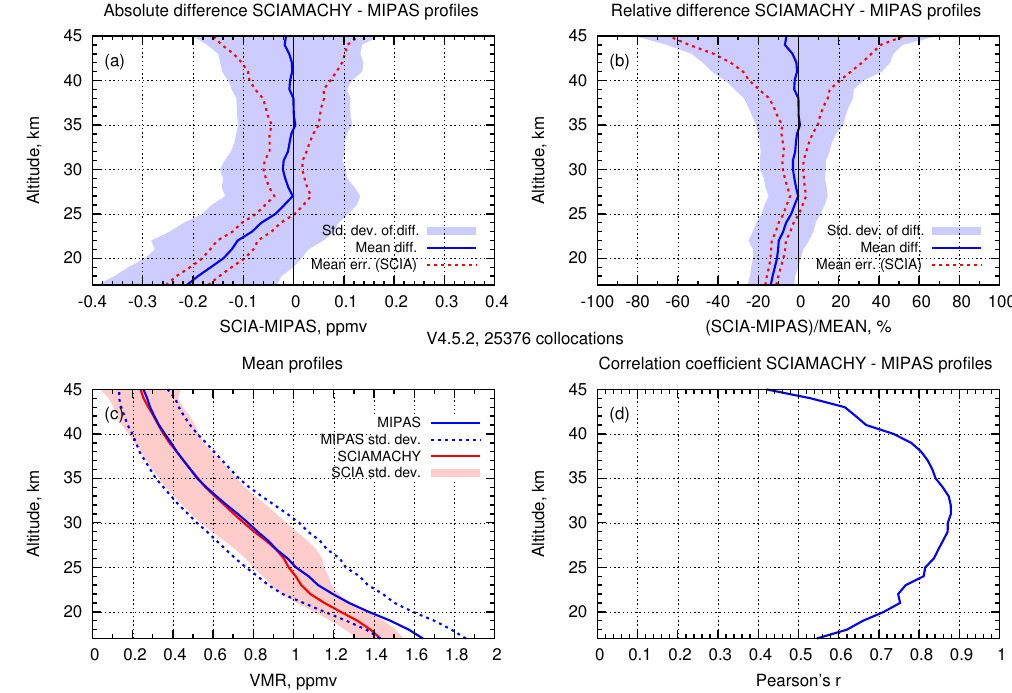
Figure 10. Same as Fig. 8, but for comparison of retrieved SCIAMACHY CH 4 profiles (ONPD V4.5.2, red) with MIPAS data (blue).